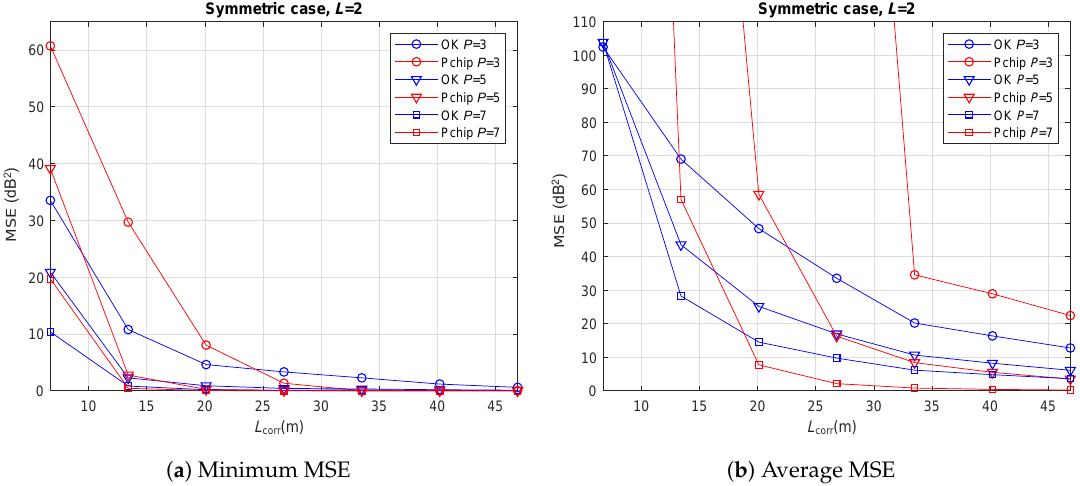
Figure 5. Path-loss and shadowing estimation results versus shadowing correlation distance in the symmetric case with L = 2